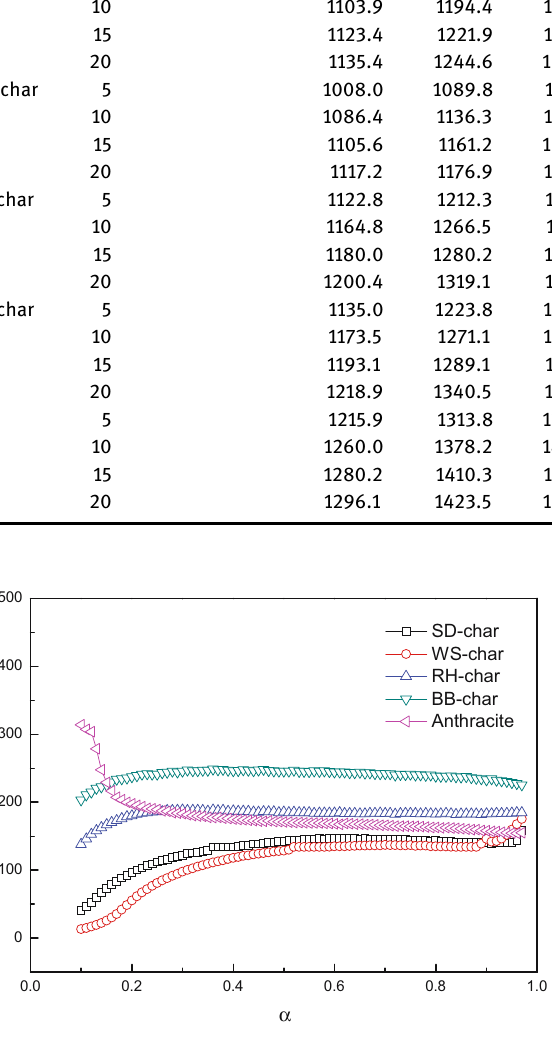
Figure 4: Relation between activation energy and conversion for di ff erent biochars and